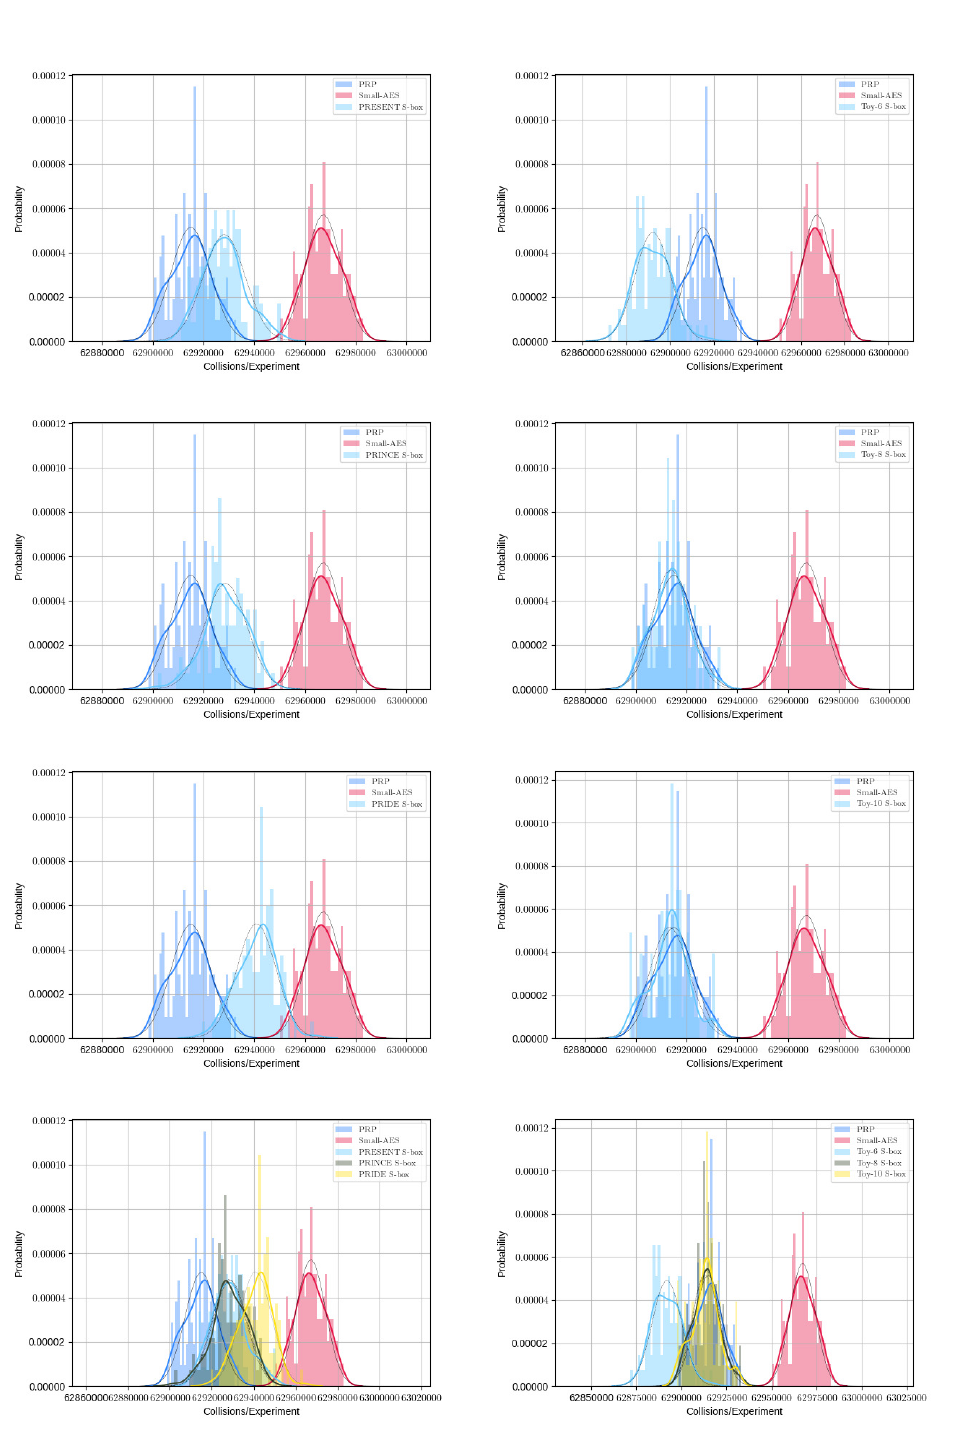
Figure 20: Distribution of means from 100 experiments with random keys for our four-round dis- tinguisher on variants of Small- AES with different S-boxes. Each experiment used 2 23 independent δ